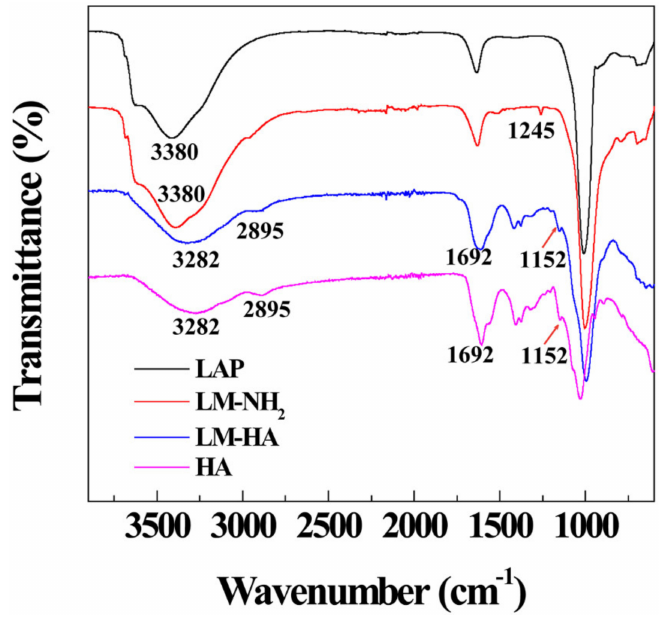
Figure 2. FT-IR spectra of LAP, LM-NH 2 , LM-HA, and